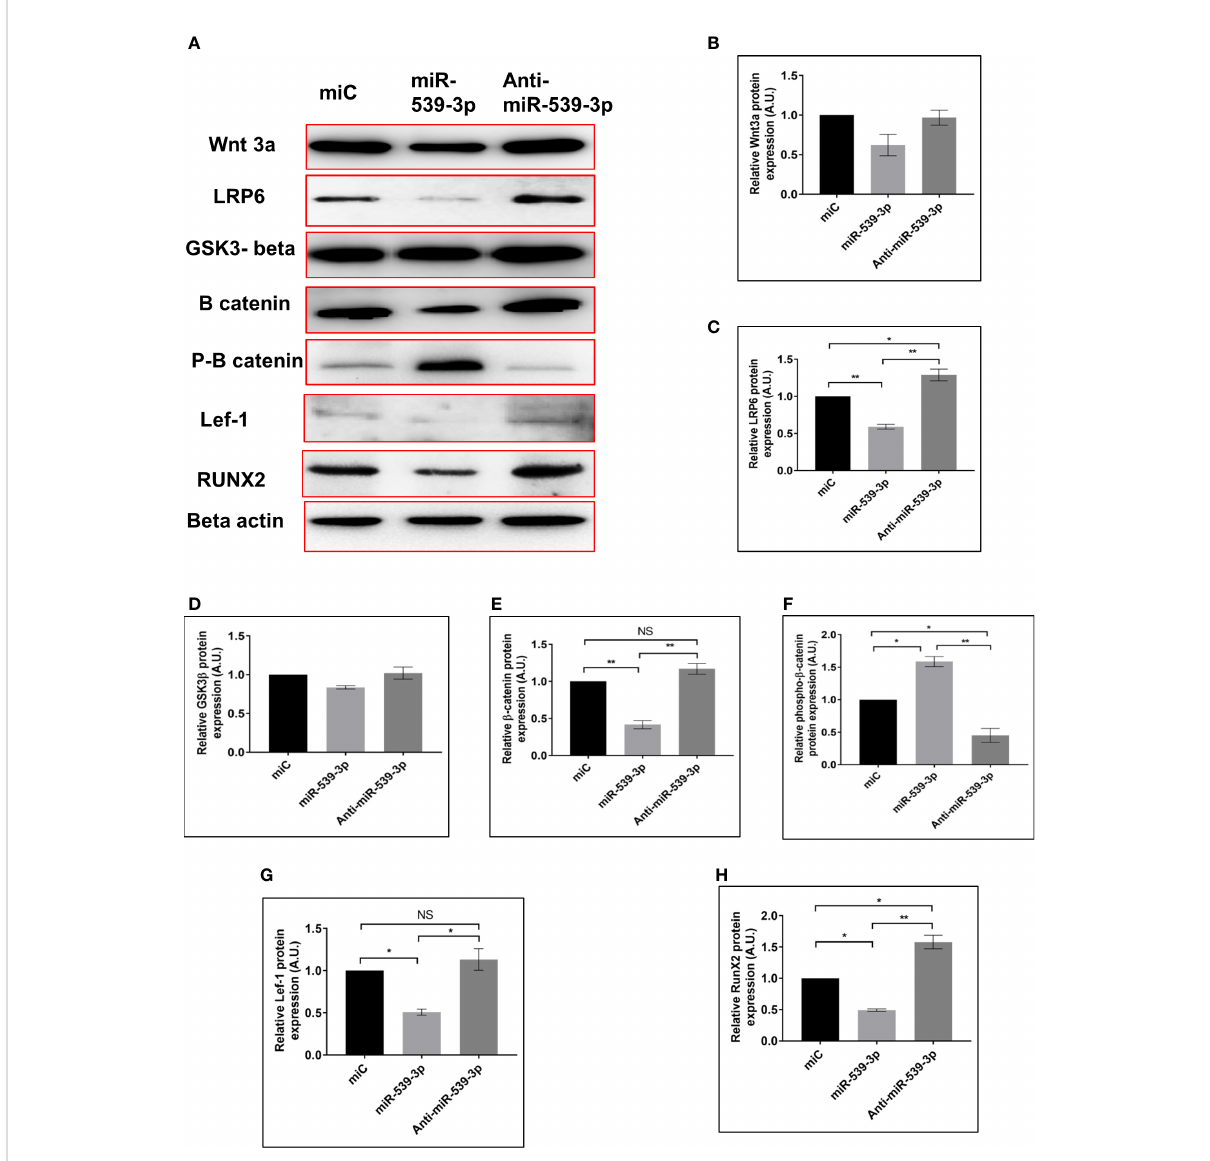
FIGURE 4 miR-539-3p inhibits osteoblast differentiation by regulating the LRP-6 wnt/beta catenin signalling pathway. (A) Cell lysate was obtained 48 h after transfection with miC, miR-539-3p, and anti-miR-539-3p, and immunoblotting of Wnt3a, LRP-6, GSk3beta, catenin, P-catenin, Lef-1and RunX-2 was done. As an internal control, beta actin was employed. (B – H) The relative expression of proteins was quanti fi ed densitometrically by using ImageJ software. All data represent mean ± SE (n = 3). *p < 0.05, **p < 0.01 and NS, non-signi fi cant compared between miC. miR-539-3p and anti-miR-539-3p